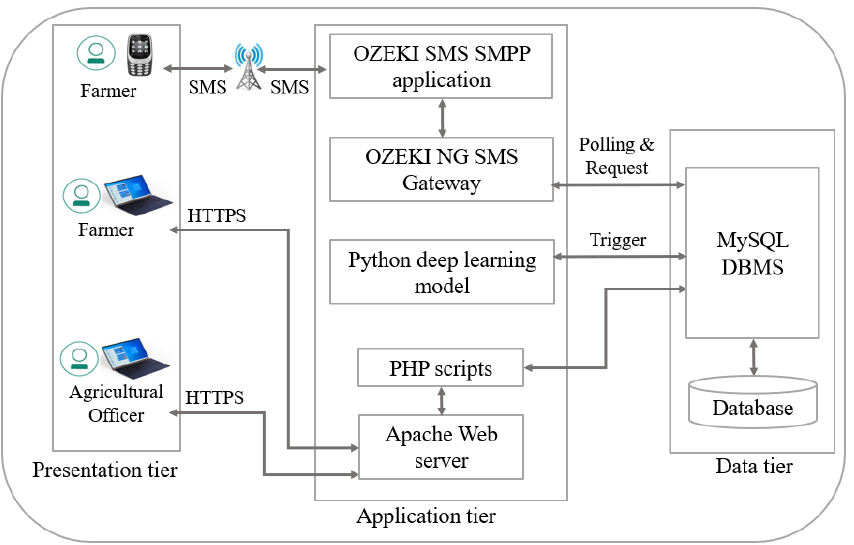
Figure 4. System design based on 3-tier